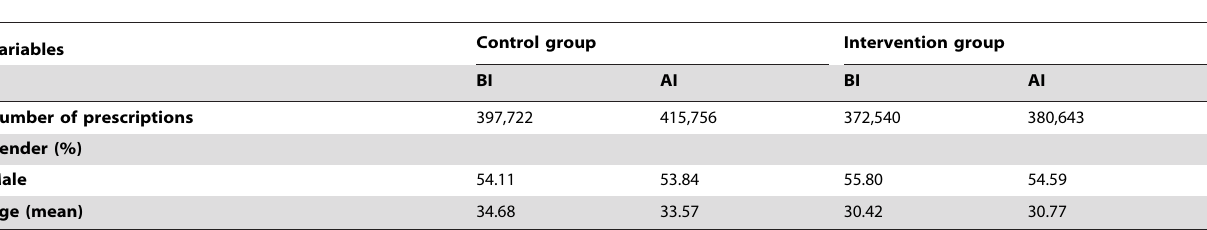
Table 3. Basic characteristics of the